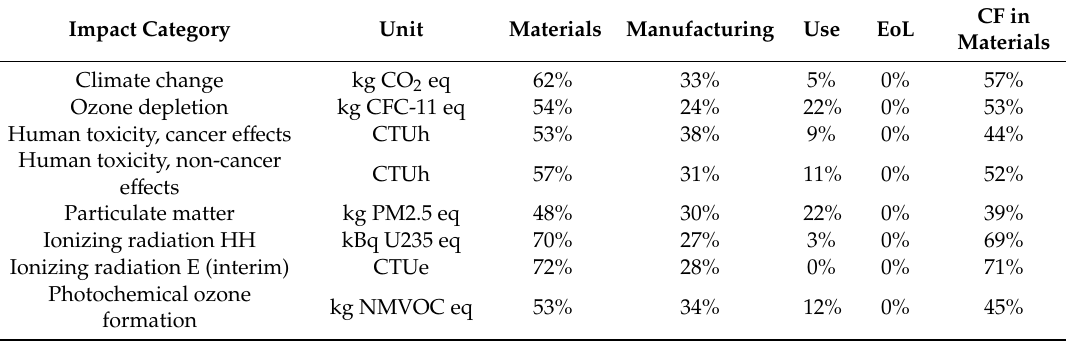
Table A3. Percentage contribution of each inventory aspect to each impact category for the Sleekfast sailing